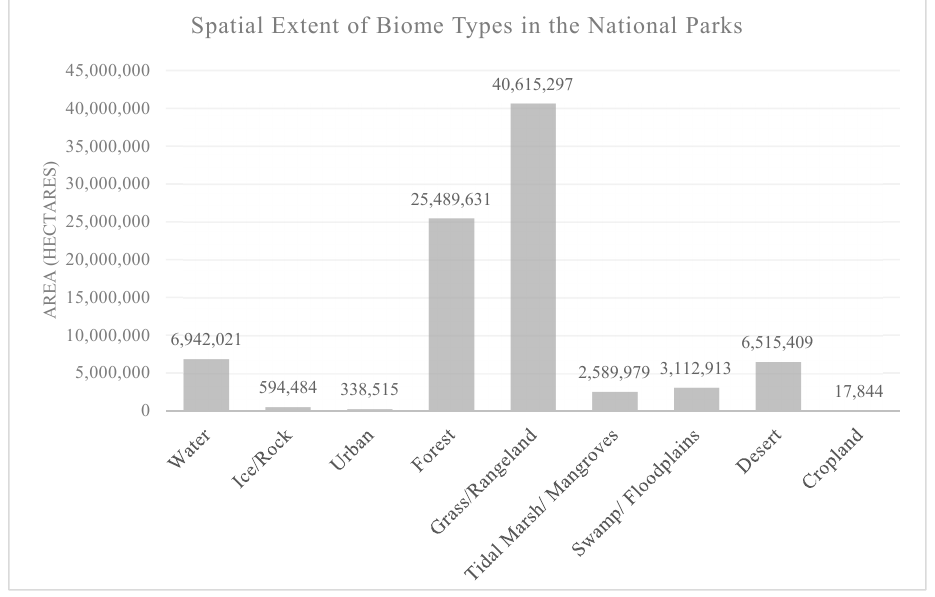
Figure 1. The spatial extent of each biome type in the National Parks in the conterminous United States.